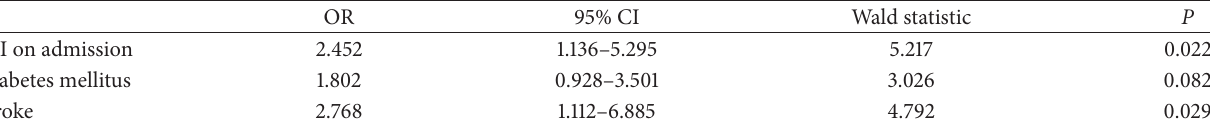
Table 6: Multivariate analysis for risk factors for bloodstream infections (BSI) in all analyzed patients.